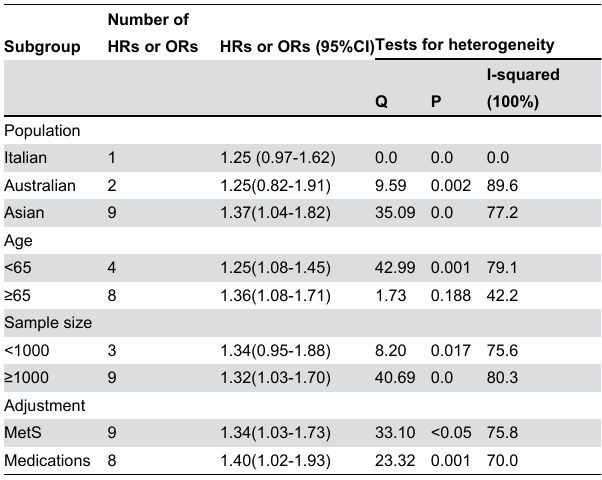
Table 2. Stratified analysis to summary odds ratio for the relationship between SUA and T2DM vascular complications.